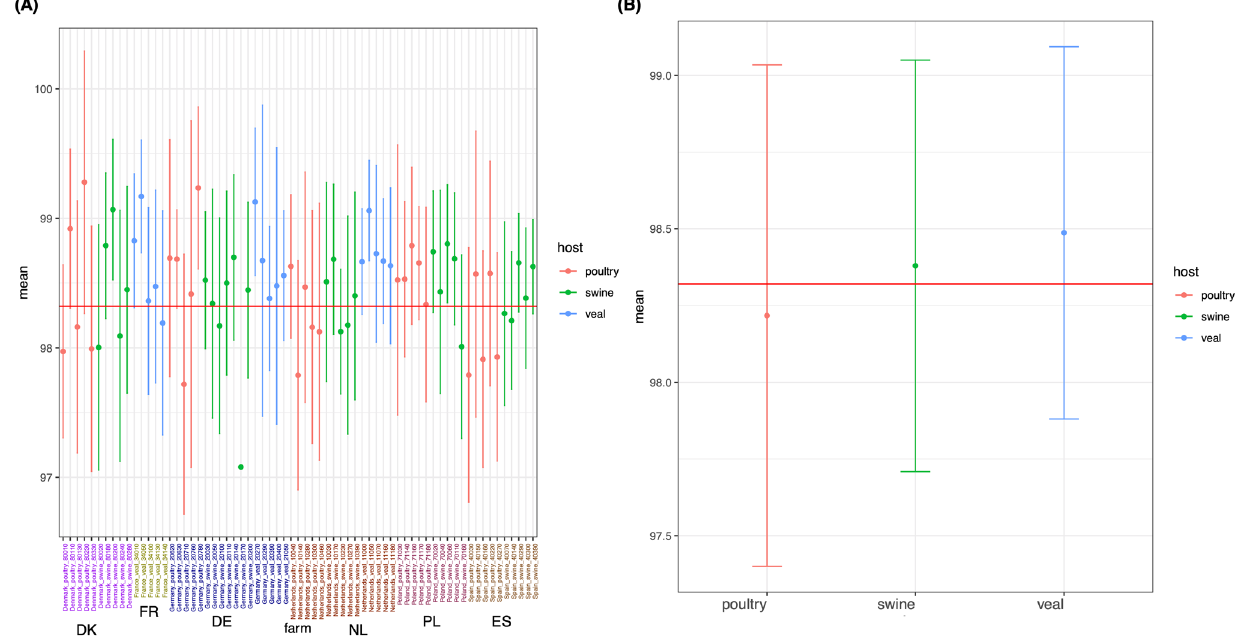
Figure 2. Average nucleotide identity in mean percent identity of E. coli isolates from the same farm ( A ) and from the same animal host ( B ). DK Denmark, FR France, DE Germany, NL The Netherlands, PL Poland and ES Spain. Vertical line represents points within 1st/3rd + 1.5 IQR. A red horizontal line indicates mean of overall nucleotide identity